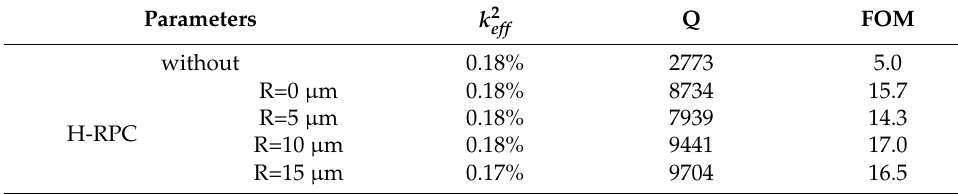
Table 5. FOM comparison after adding